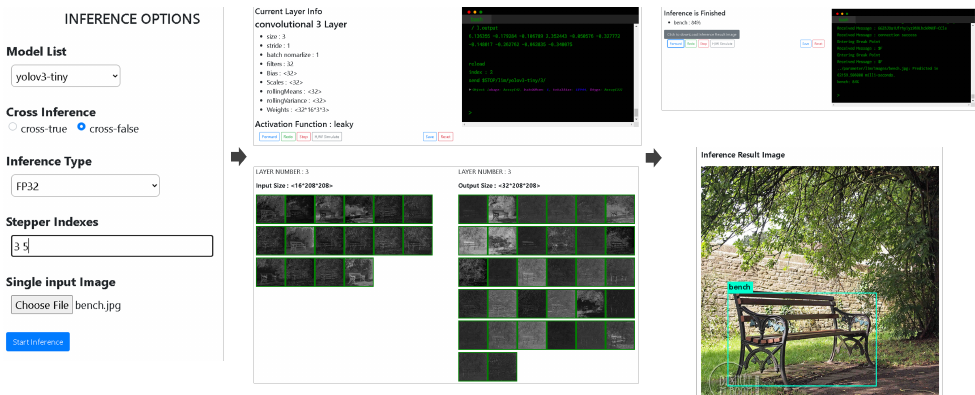
Figure 8. GUI interfaces to setting inference options, running inference through inference engine or hardware DLS VP, and its resulting